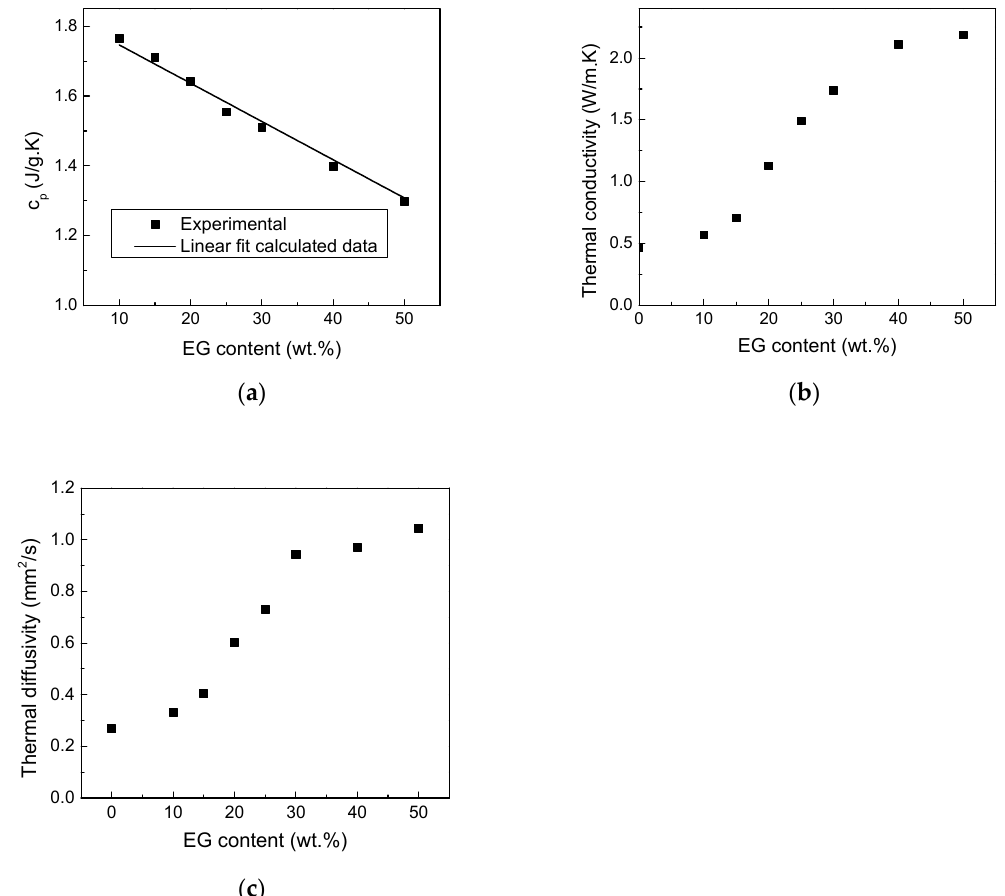
7 of 19 3.1. Thermo-Physical Properties The specific heat capacity ( 𝑐 (cid:2926) ) of pure HDPE and EG and their composites was measured by DSC and the results are shown in Figure 2a. The specific heat capacity of the composite samples decreases linearly with EG loading following an additive mixture rule (Equation (1)) represented by the solid line in Figure 2a, confirming the dense nature of the composite and the absence of any voids or air bubbles. 𝑐 (cid:2926),(cid:2913) = 𝑐 (cid:2926),(cid:2926) (cid:4672)1 − (cid:3050) (cid:3164) (cid:2869)(cid:2868)(cid:2868) (cid:4673) + 𝑐 (cid:2926),(cid:2916) (cid:3050) (cid:3164) (cid:2869)(cid:2868)(cid:2868) (1) where 𝑐 (cid:2926),(cid:2926) is 𝑐 (cid:2926) of neat HDPE (1.84 Jg ⁻ 1 C ⁻ 1 ) and 𝑐 (cid:2926),(cid:2916) is 𝑐 (cid:2900) of EG (0.76 Jg ⁻ 1 C ⁻ 1 ) Moreover, the thermal transport parameters, λ and α , provided in Figure 2b,c revealing that the